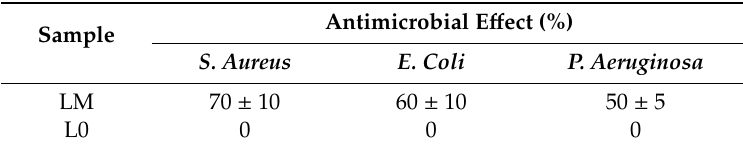
Table 8. Antimicrobial e ffi ciency of non-pigment coating films (test on imprints).